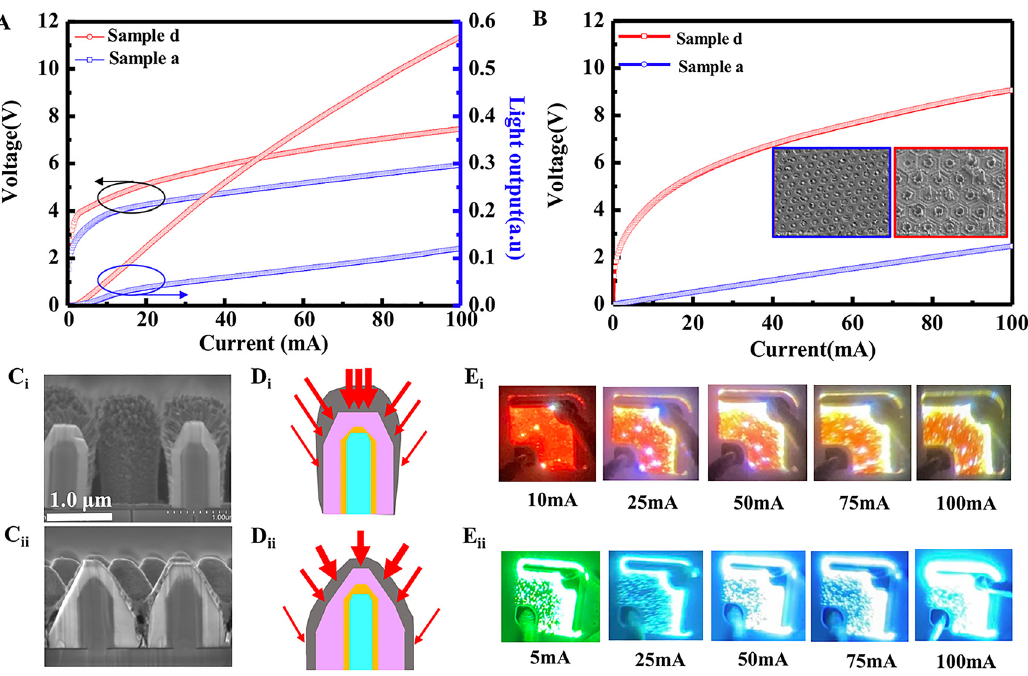
Figure 5: I – V – L curves, SEM images, and corresponding luminescence photos of LEDs in samples a and d. (A) I – V characteristics and light output in samples a and d having different growth rates. (B) I – V characteristics of between n – n electrodes in samples a and d, respectively. SEM images of the electrode surface fabricated after ultrasonic or ICP dry etching are shown in the inset. (C i ) – (C ii ) cross-sectional SEM images of NWs in samples a and d after the fabrication process. (D i ) – (D ii ) schematic images of the current injection along NWs in samples a and d. Panels (E i ) and (E ii ) show the luminescence photos of LED chips in samples a and d,